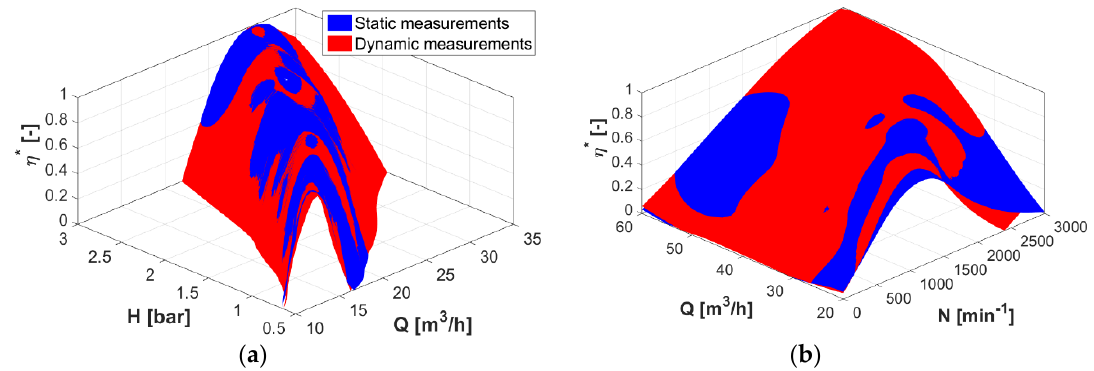
Figure 13. Validation of resulting 3D hill-charts obtained by the dynamic measurements method with the results of the classical static point-by-point method: ( a ) comparison for the counter-rotating microturbine; ( b ) comparison for the PAT.